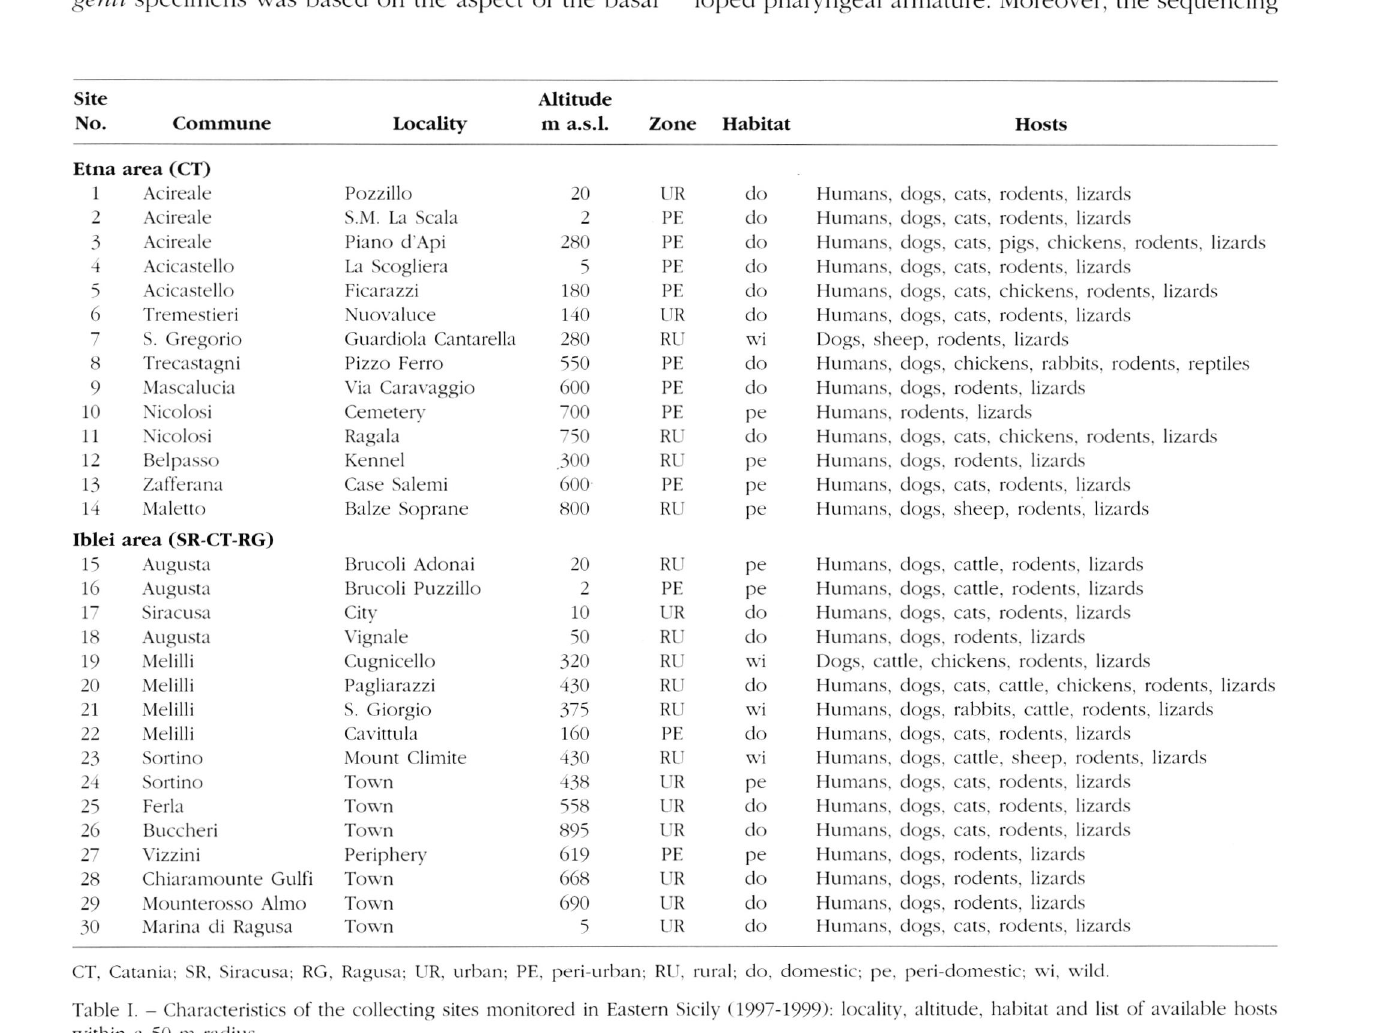
Table I. - Characteristics of the collecting sites monitored in Eastern Sicily ( 1997-1999); locality, altitude, habitat and list of available hosts within a 50 m radius.